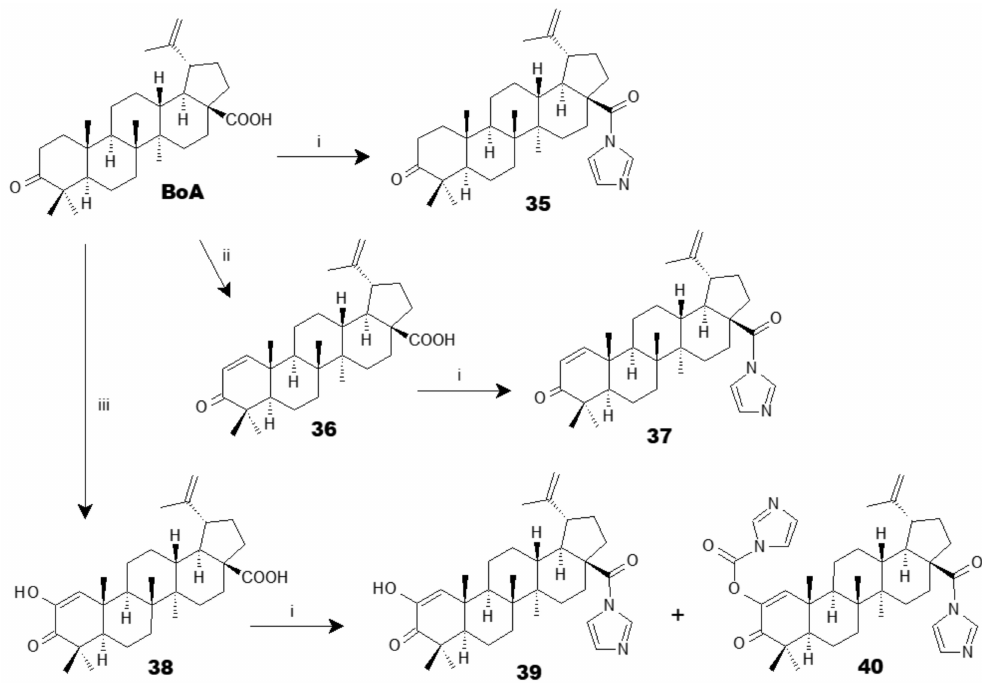
Scheme 9. Synthesis of imidazole BA analogues [61]. Reagents and conditions: ( i ) CDI, dry THF, N 2 , reflux, 8–9 h; ( ii ) DDQ, dioxane, N 2 , reflux, 15 h; ( iii ) O 2 , t -BuOK, t -BuOH, 40ºC, 2